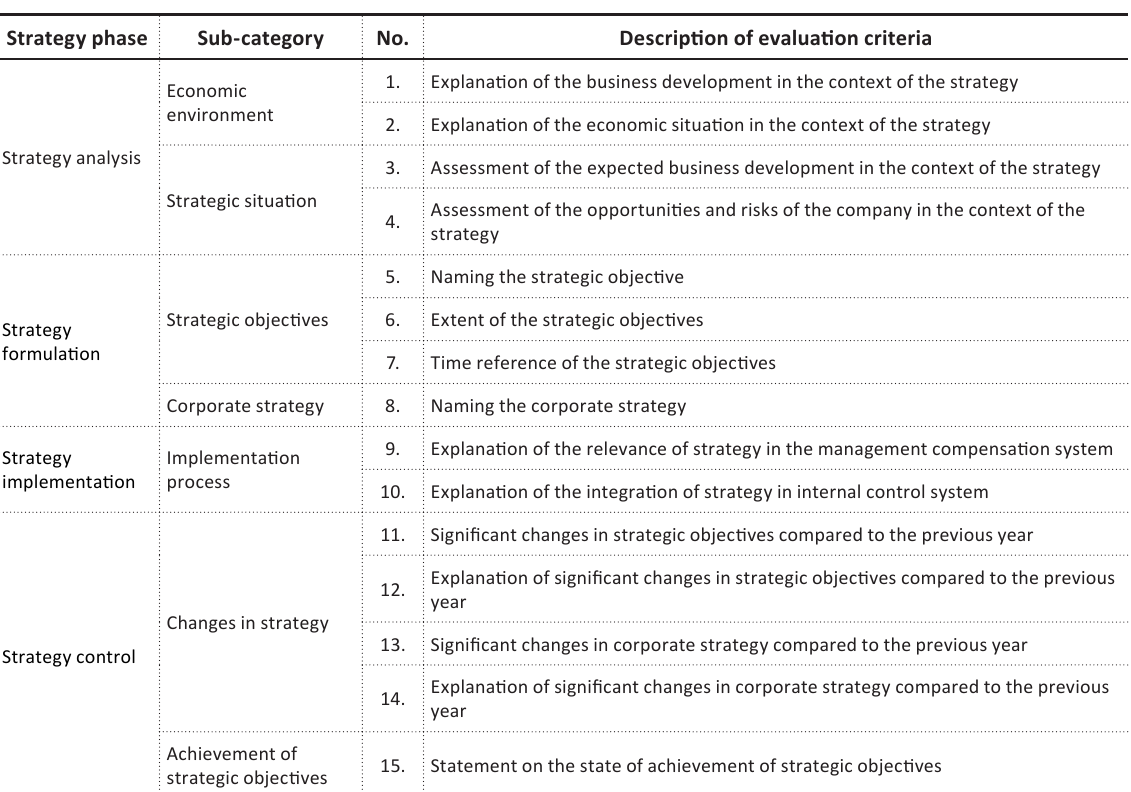
Table A1. Data collection